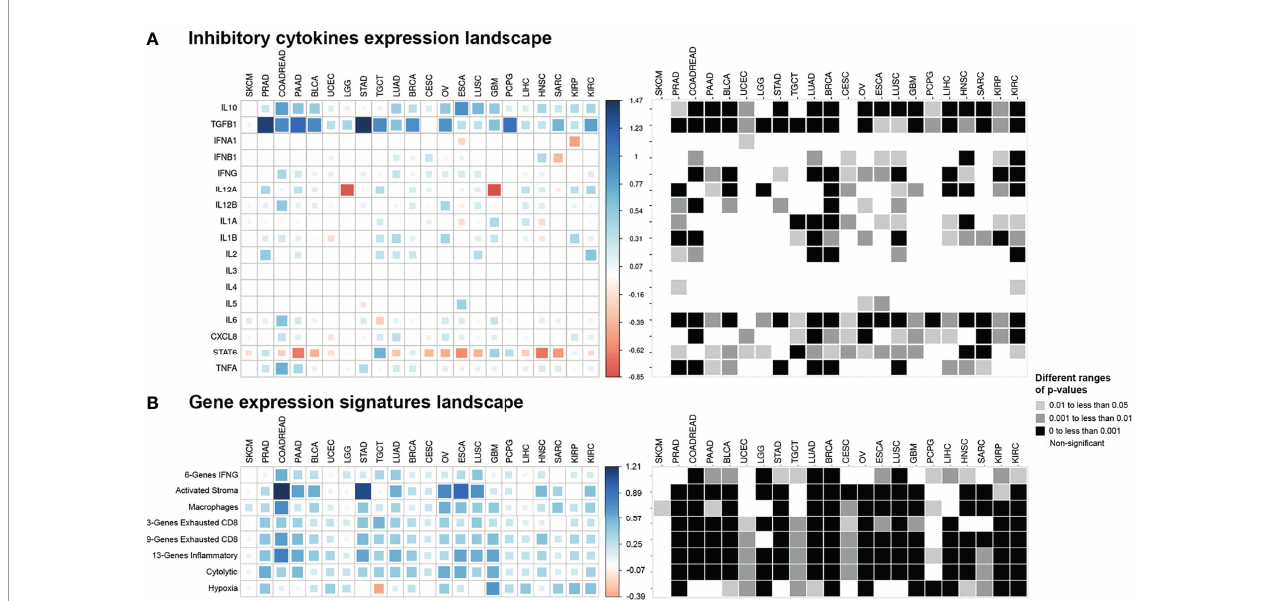
FIGURE 6 | Pan-cancer cytokines expression and gene expression signatures landscape. The colored squares represent the difference between: (A) the medians of expression of cytokines in EMT-high and EMT-low samples of each cancer type and (B) the medians of gene expression signatures in EMT-high and EMT-low samples of each cancer type. The larger sized and darker blue or red shaded squares correspond to the greater difference. Greyscale squares on the right side represent the corresponding p-values for differences between EMT-high and EMT-low groups of